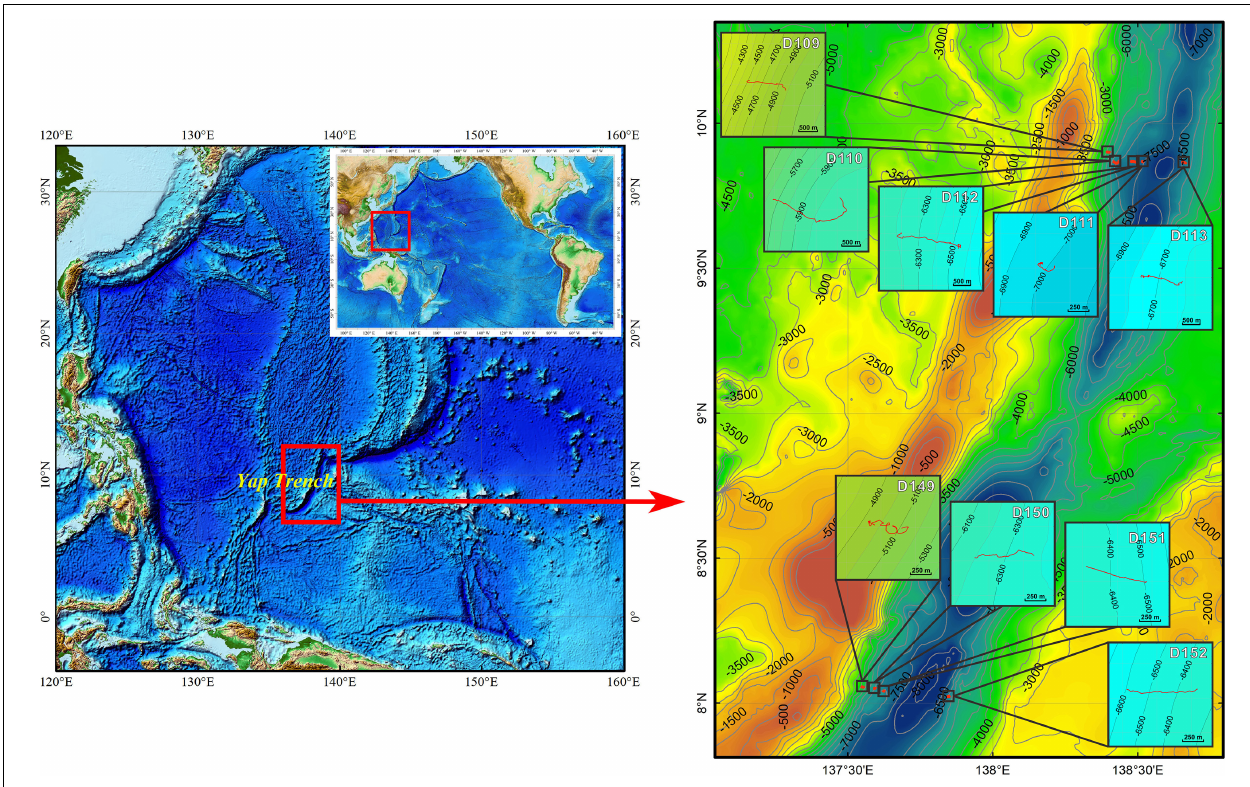
FIGURE 1 | Study area and “ JIAOLONG ” diving sites in the Yap Trench.